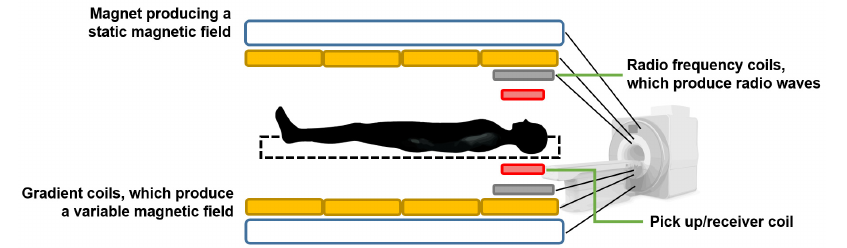
Figure 13. Illustration of a nuclear magnetic resonance tissue flowmeter.